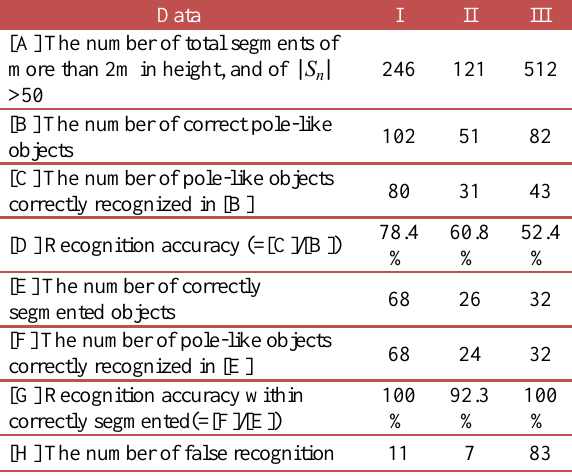
Table 2. Accuracy of the proposed method